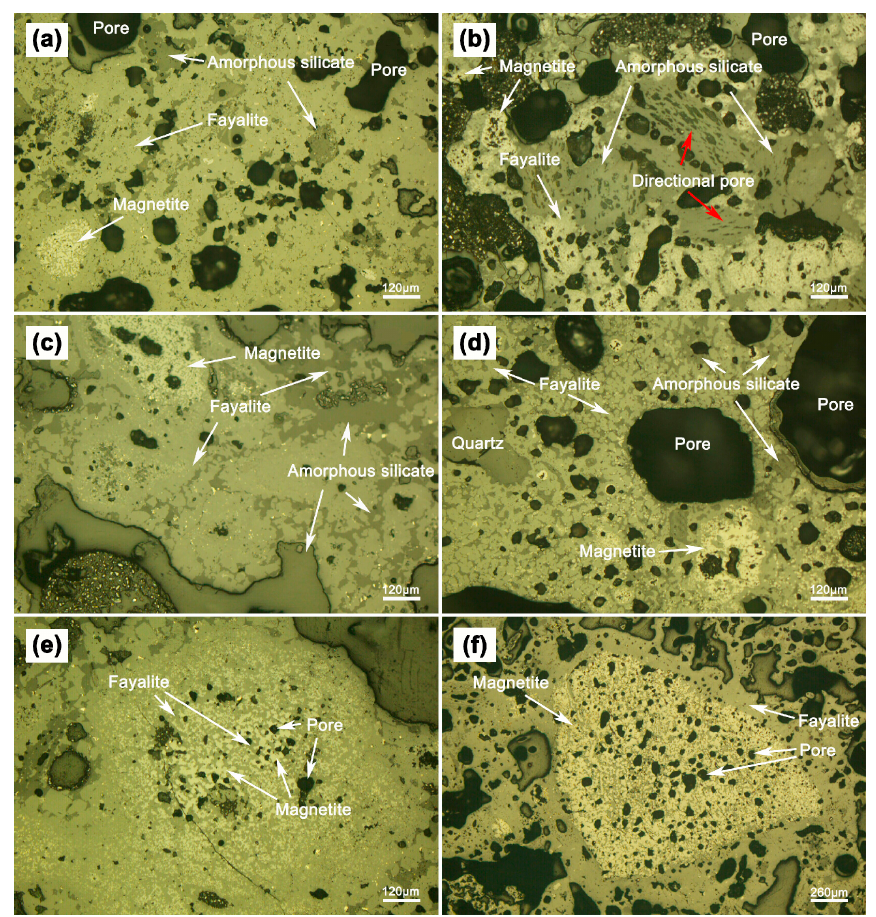
Figure 4. Polarized microscopic images of ( a ) internal deposit (S2); ( b ) external deposit (S1); ( c ) air duct deposit (S3); ( d ) deposit containing independent quartz; ( e ) infiltrated magnetite phase; ( f ) granular magnetite phase.